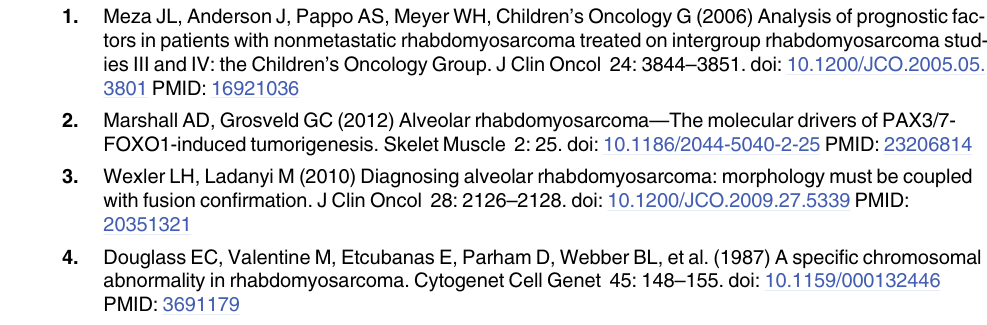
S1 Table. PAX3-FOXO1 target genes in ARMS. List of genes reported to be regulated by PAX3-FOXO by comparing gene expression levels in ARMS versus ERMS tumors and by forced expression of PAX3-FOXO1 in MEFs, NIH3T3, SAOS2 and C2C12 as published in [2] and ref- erences therein. The last column lists the up or down regulated genes in 64% t(1;3)-positive mouse myoblasts. These numbers were obtained by dividing the number of mapped RNA-seq reads in 64% Pax3-Foxo1 -positive (1G3) cell pool by those in the wild type (1H3) cell pool. 45% of the genes (bold script) are regulated in the direction published. ND = no reads detected. (XLSX) S2 Table. PAX3-FOXO1 expression signature in PAX3-FOXO1 transduced cells. List of genes regulated by PAX3-FOXO1 in the ERMS cell line RD transduced with a PAX3-FOXO1 retrovirus as reported by [50]. The last column lists the up or down regulated genes in 64% t(1;3)-positive mouse myoblasts. These numbers were obtained by dividing the number of mapped RNA-seq reads in the 64% Pax3-Foxo1 -positive (1G3) cell pool by those in the wild type (1H3) cell pool. 52% of the genes (bold script) are regulated in the direction published. ND = no reads detected. (XLSX) S1 Protocol. Strains of E. coli. PCR primers and oligonucleotides. Identification of the trans- location breakpoints in ARMS.